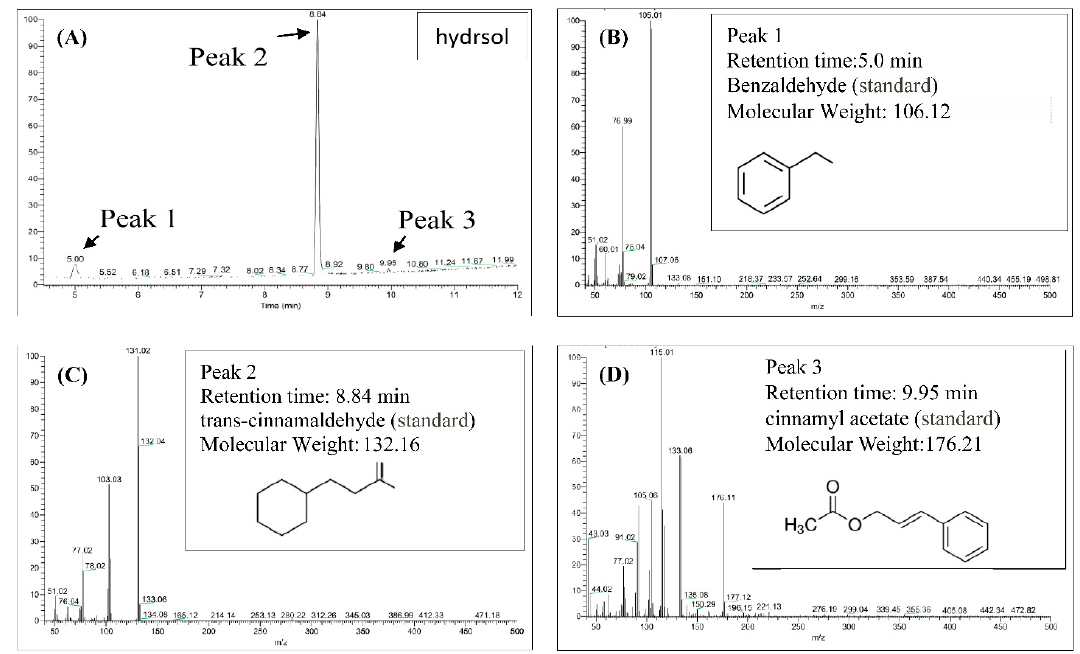
Figure 2. Gas chromatography / mass spectrometry (GC / MS) chromatograms of the major constituents of hydrosol from Cinnamomoum osmophloeum Kanehira (COK) leaves. ( A ) Hydrosol sample; Standard chemical: ( B ) benzaldehyde; ( C ) trans-cinnamaldehyde; ( D )cinnamyl